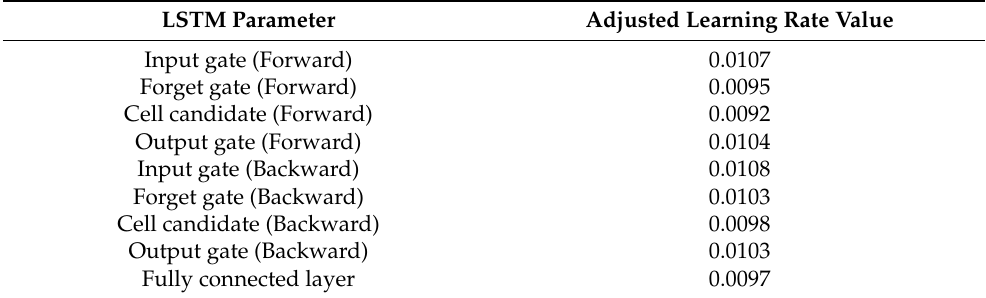
Table 4. The new learning rate values of LSTM parameters (artificial porosity images).